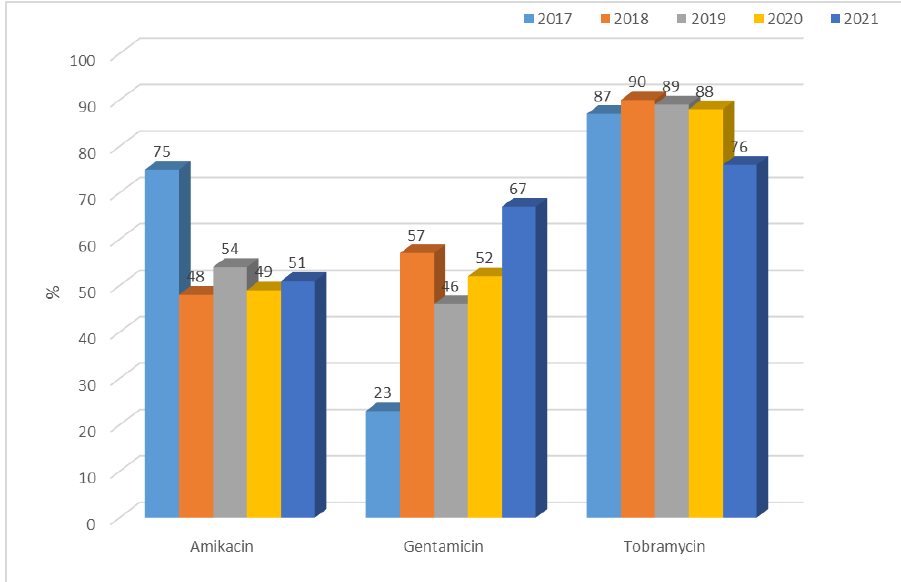
Figure 20. Percentage of K. pneumoniae ESBL(+) strains resistant to aminoglycosides.